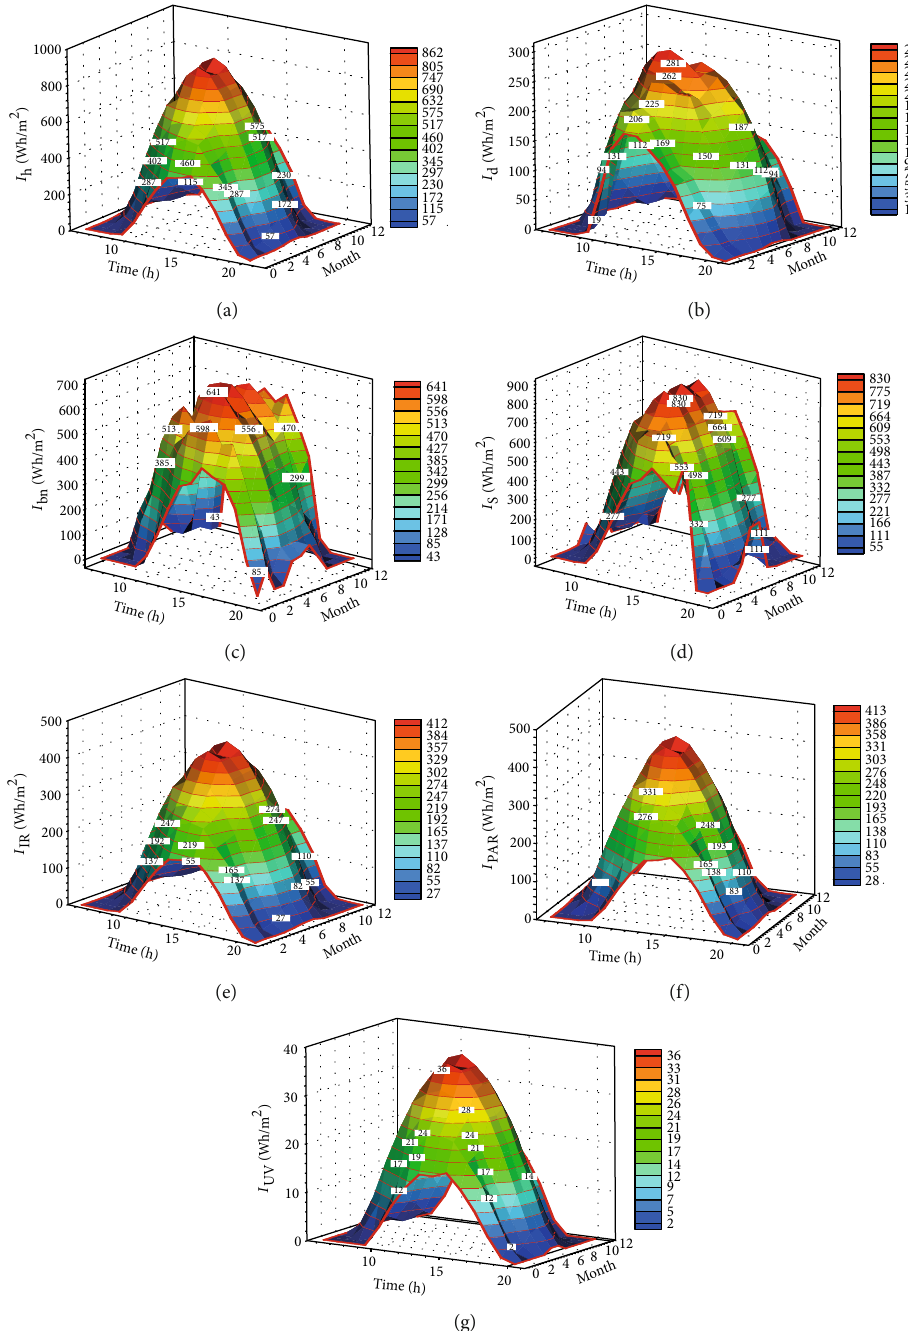
Figure 10: Annual variation of hourly radiation: (a) global solar radiation, (b) di ff use solar radiation, (c) direct solar radiation, (d) inclined solar radiation, (e) infrared I IR solar radiation, (f) photosynthetically active radiation I PAR , and (g) ultraviolet I UV solar